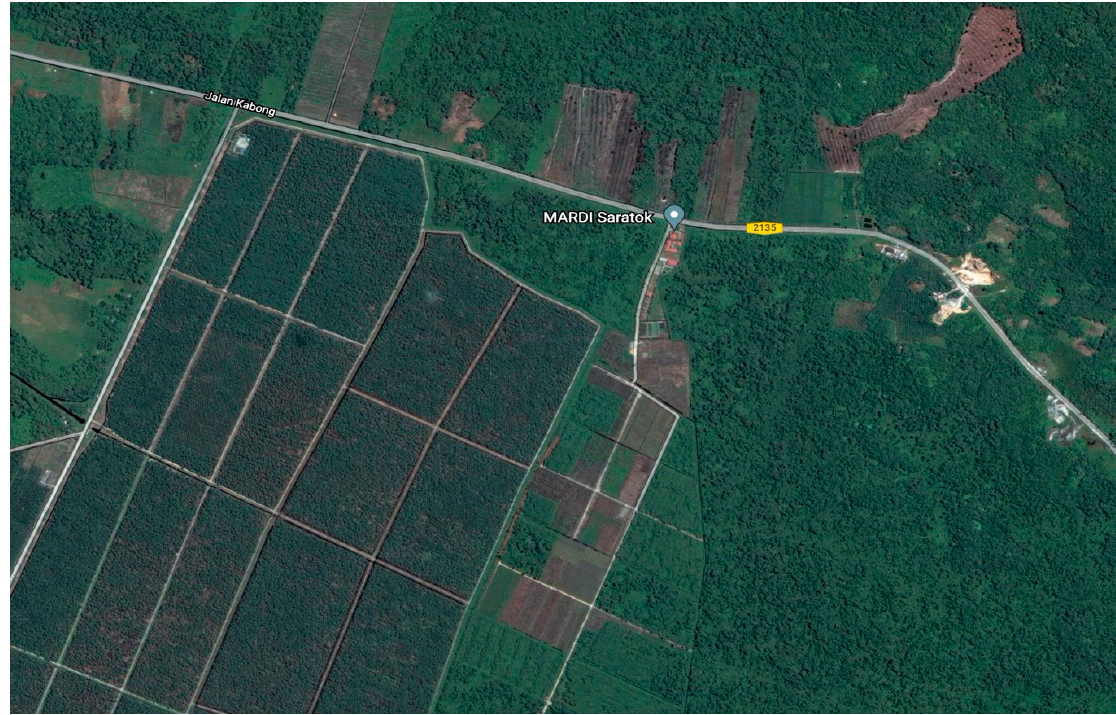
Figure 1. Location of study site in Sesang, Saratok, Sarawak, Malaysia .